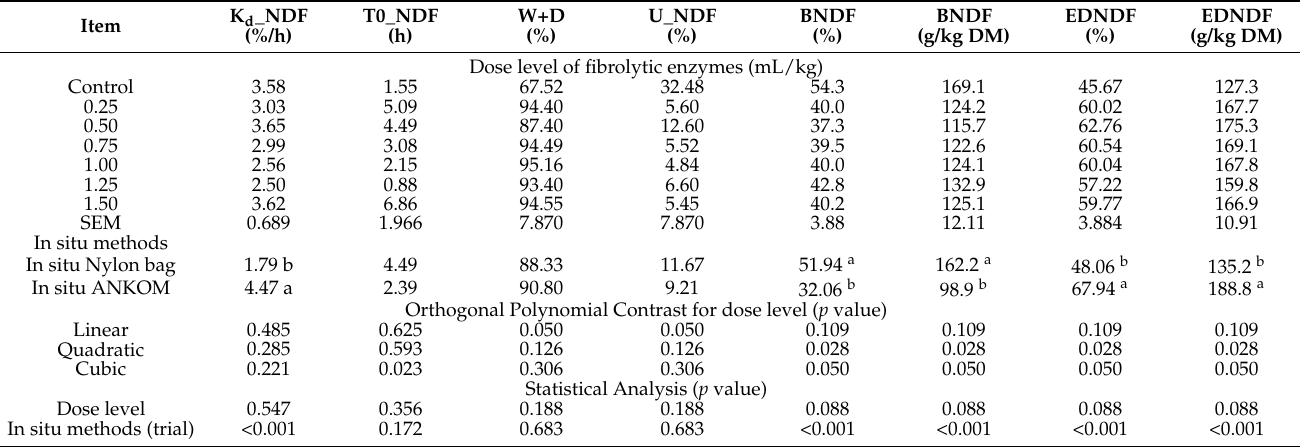
Table 6. Effect of dose level of fibrolytic enzymes 1 derived from Trichoderma reesei on in situ rumen NDF degradation kinetic of whole plant faba bean silage using both in situ nylon bag and in situ ANKOM